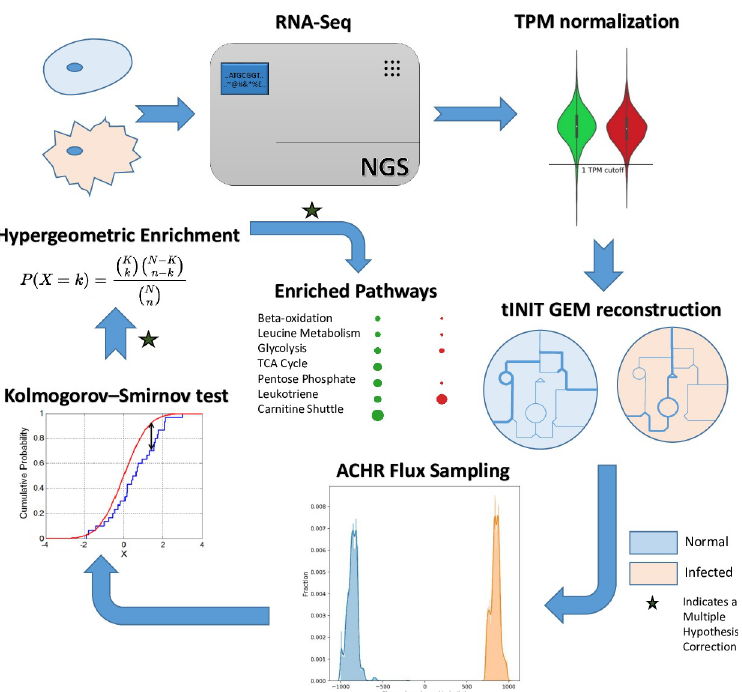
Fig 5. The pipeline for GS-DFA beginning from RNA-seq of infected and normal cell line, followed by construction of context specific models, flux sampling, reaction filtering and over-representation analysis of pathways. The ‘star’ symbol indicates a multiple hypothesis correction step through Benjamini-Hochberg False Discovery Rate. A two-sample Kolmogorov-Smirnov test is used to differentiate between the probability distribution of flux between diseased and non-diseased